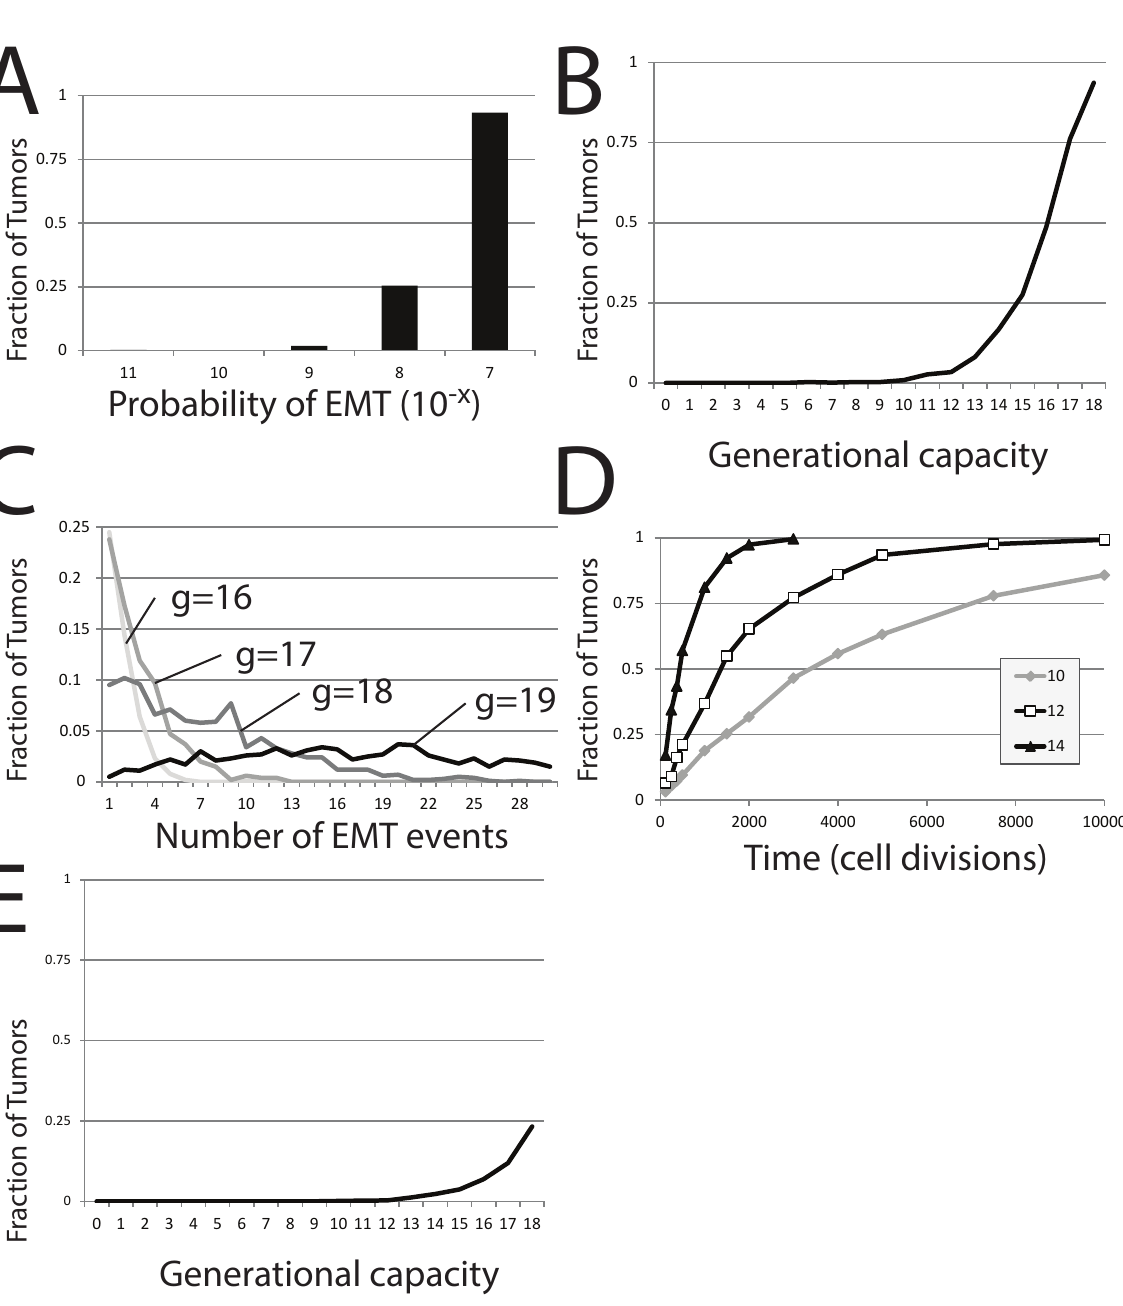
Figure 7. EMT in a stochastic model of dormant tumor recurrence. ( A ) The fraction of tumors in which EMT events occur with a fixed generational capacity of 18 and for different probabilities of EMT; ( B ) the fraction of tumors in which EMT events occur with a varied generational capacity and fixed probability of EMT; ( C ) the fraction of tumors exhibiting specific numbers of EMT events as generational capacity is altered; ( D ) the fraction of tumors exhibiting occurrences of EMT over time, for three different generational capacities; ( E ) the fraction of tumors in which EMT events occur with a varied generational capacity of 18 and fixed probability of EMT. In ( A – C ), tumors were initiated from a single precursor M cell; while in ( D ), tumors were started from a population of 100 E cells. The probability of EMT in ( B – E ) was set at 10 − 7